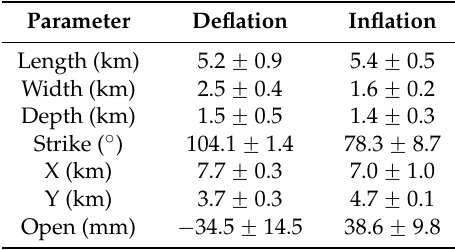
Table 1. Parameters for the best-fitting model sill (see text for details). Uncertainties correspond to 95%